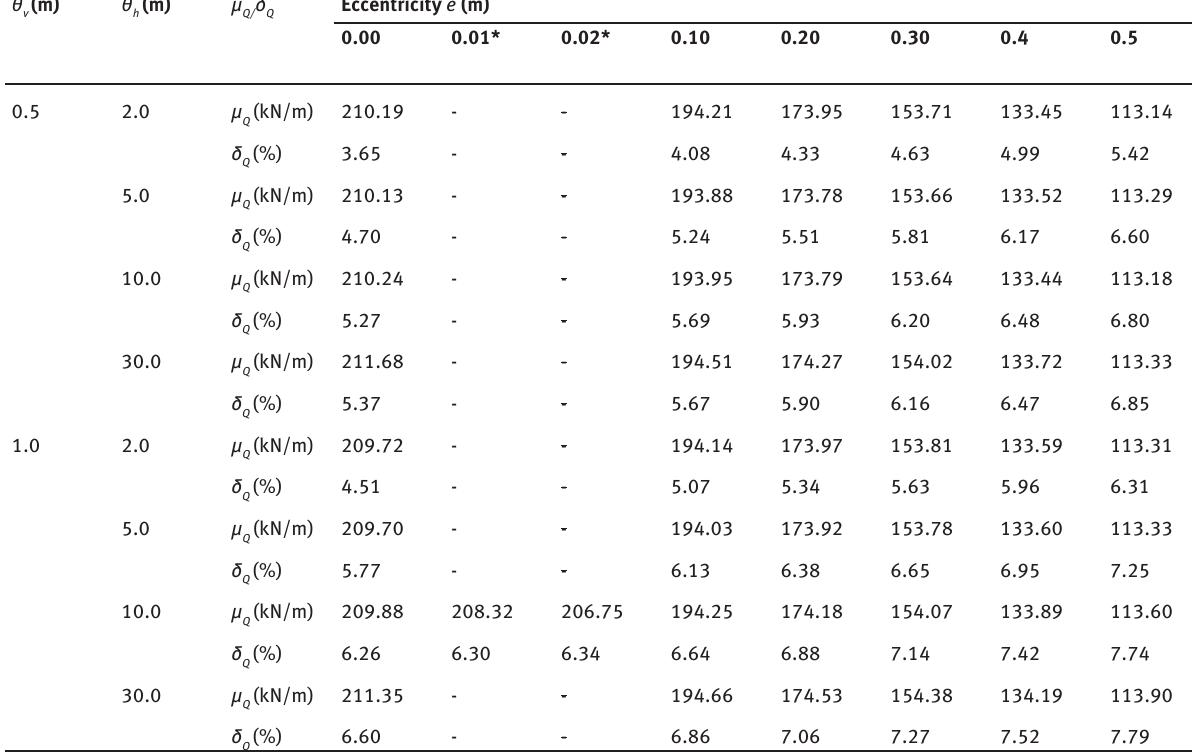
Table 3: Obtained and interpolated values of μ θ (m) v